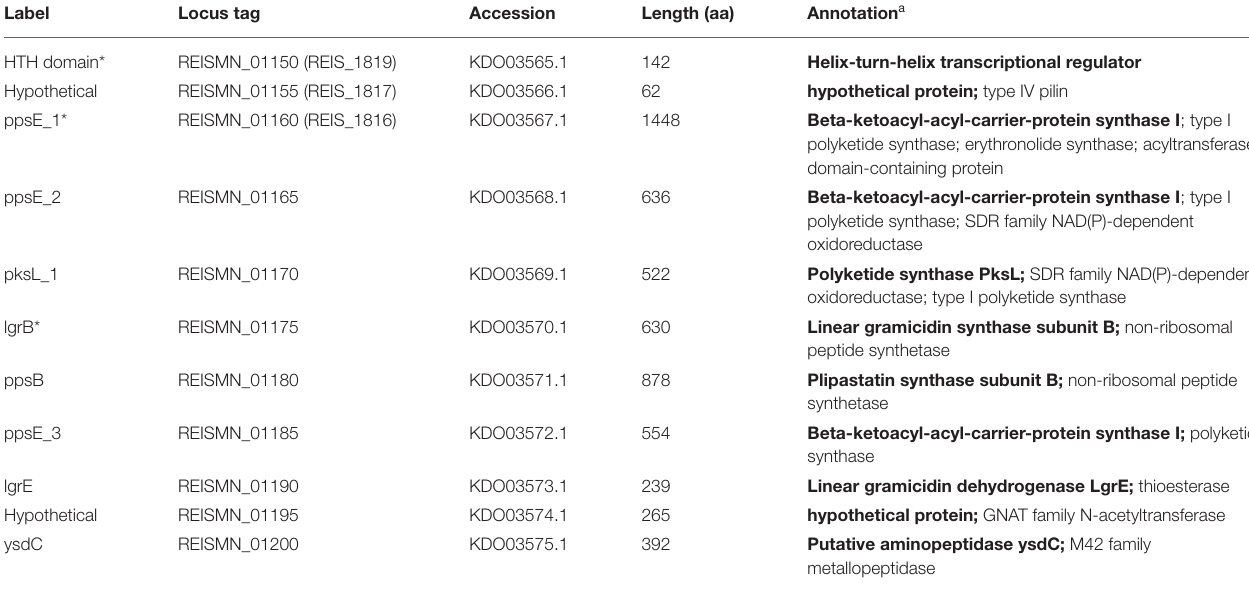
TABLE 2 | Genes in Rickettsia buchneri putative polyketide synthesis